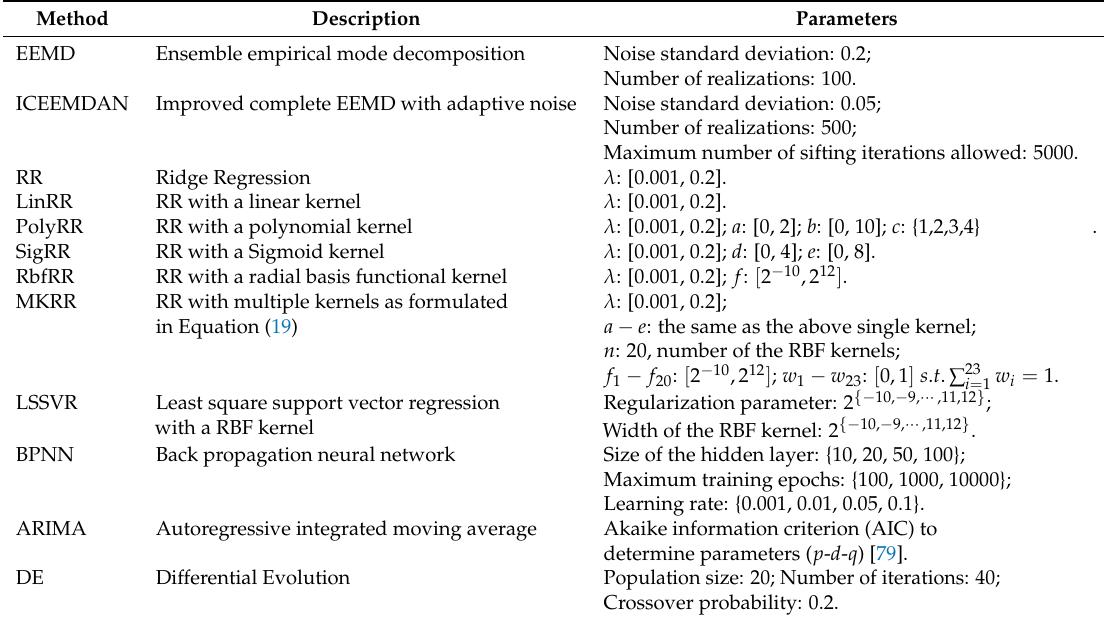
Table 1. The settings for the parameters.